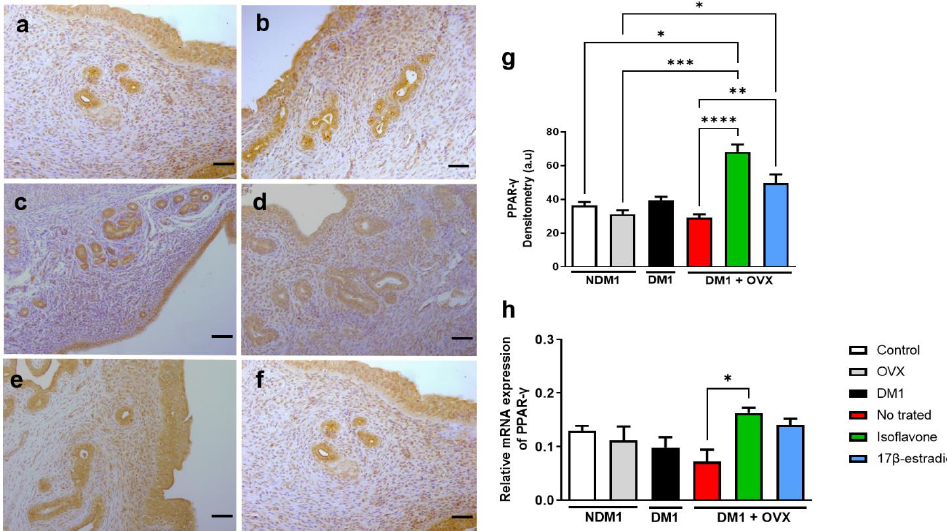
Figure 2. Isoflavone induces PPAR- γ in the endometrium. Immunoreactivity of PPAR- γ by im- munohistochemistry ( a – f ). Control ( a ), OVX ( b ), DM1 ( c ), untreated DM1 + OVX ( d ), DM1 + OVX treated with isoflavone ( e ), and DM1 + OVX treated with 17 β -estradiol ( f ). Densitometry analysis is represented in arbitrary units ( g ). Scale bar = 5 0μm. Expression of PPAR- γ mRNA with β -actin gene as endogenous control. ( h ). Values represent mean ± SEM ( n = 6). Kruskal – Wallis test was per- formed, followed by Dunn ’ s multiple comparison test (* p < 0.05; ** p < 0.01; *** p < 0.001; **** p < 0.0001).